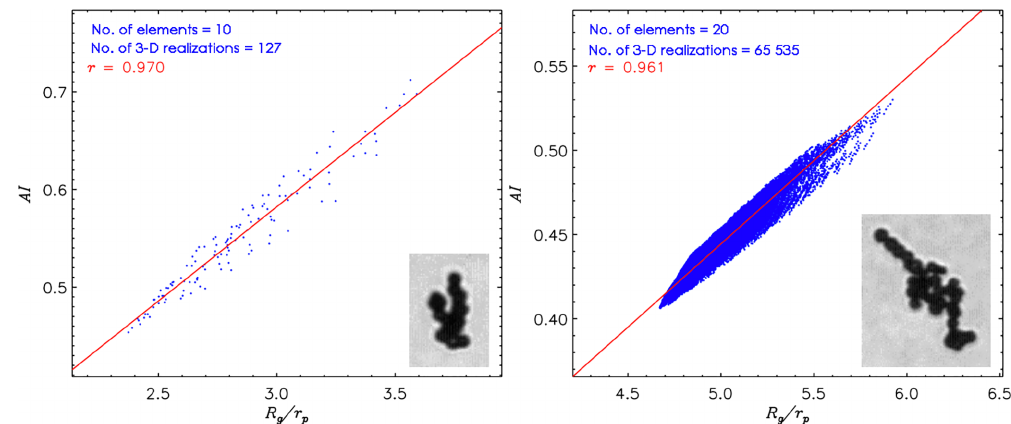
Figure 11. Relationship between aggregation index (AI) and the ratio of radius of gyration to the average radius of elements ( R g /r p ) of FDAs. The number of element frozen droplets (no. elements) and number of all possible 3-D realizations (no. 3-D realizations) are indicated. The best fit and correlation coefficient ( r ) for the relationship between the AI and R g /r p are shown in red. Corresponding CPI images of FDAs are also embedded in each